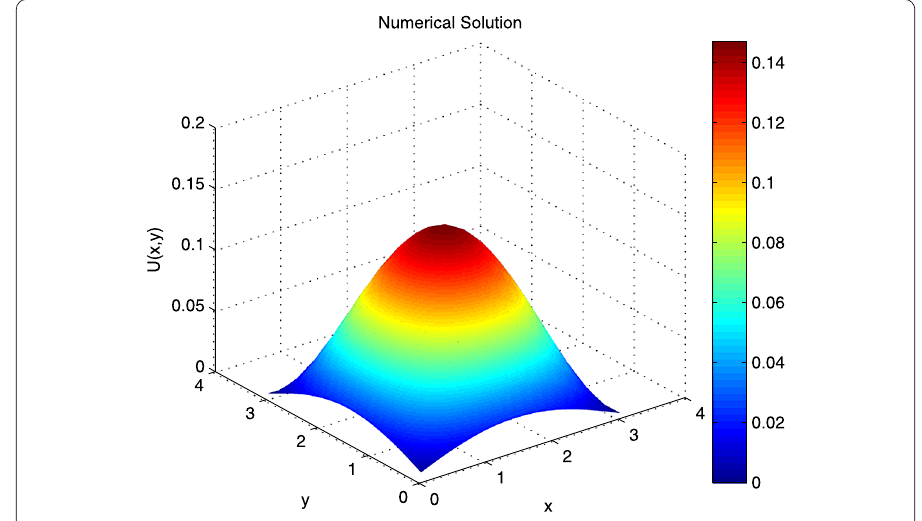
Figure 4 The profile of the numerical solution for the EFK equation with γ = 0.01 at t = T = 1.